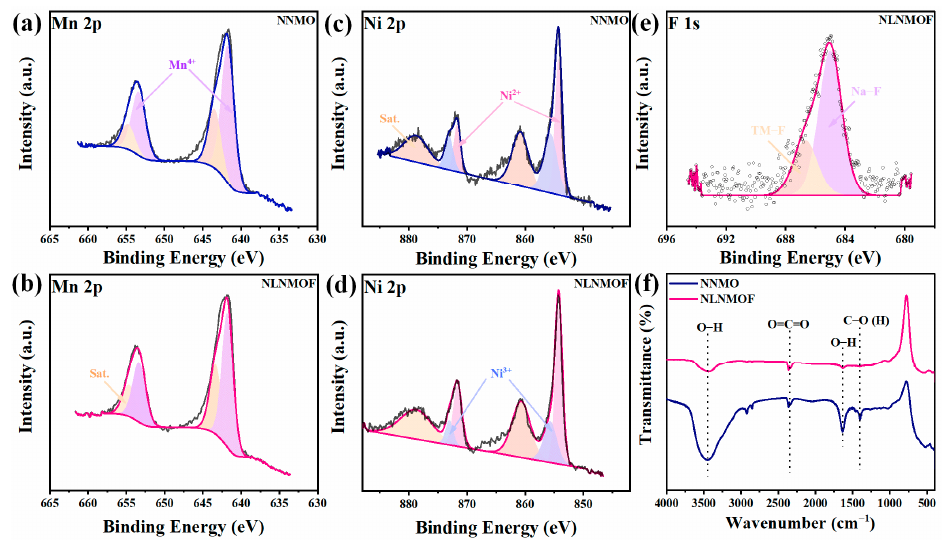
Figure 2. XPS spectra of NNMO and NLNMOF, ( a , b ) Mn 2p, ( c , d ) Ni 2p, and ( e ) F 1s. ( f ) FTIR spectra of NNMO and NLNMOF.